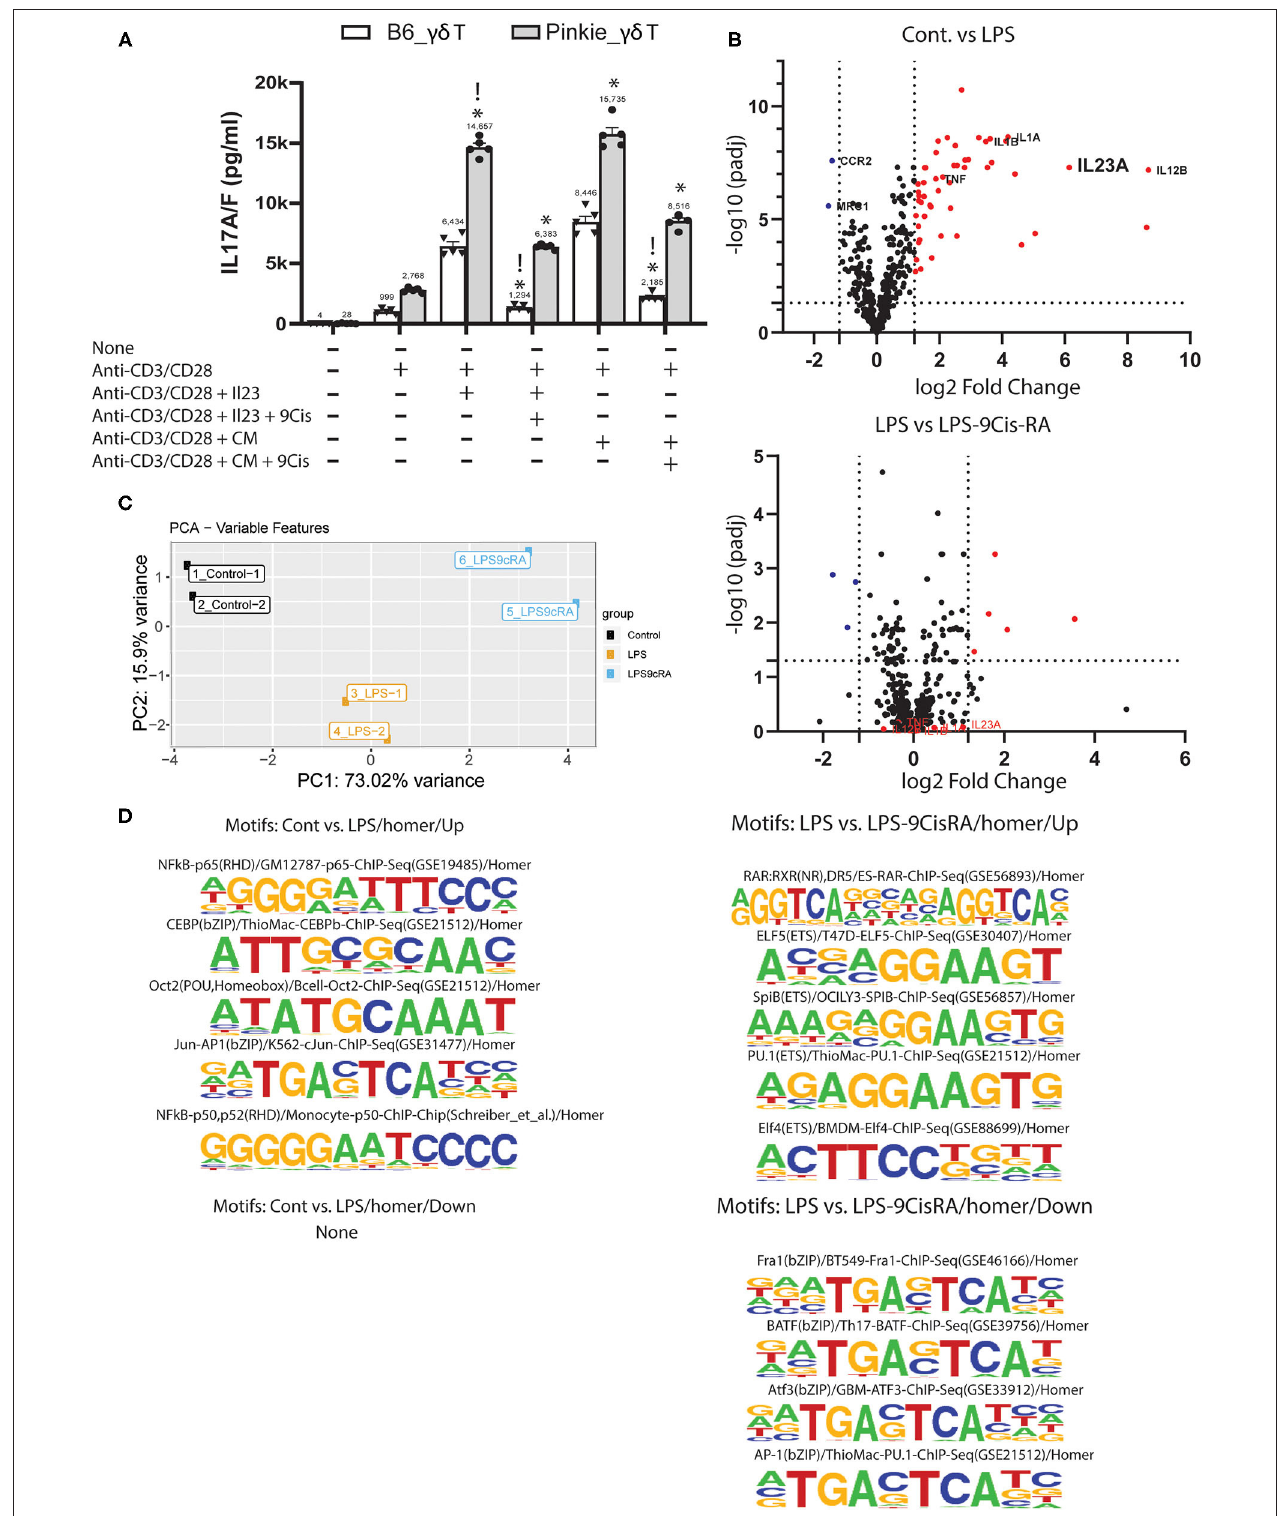
FIGURE 4 | Suppressive effects of 9-cis retinoic acid. (A) IL-17A/F concentration in supernatants of cultured γδ T cells isolated with magnetic beads from C57BL/6 or Pinkie spleens. Cells are stimulated with anti-CD3/CD28 beads or beads plus recombinant IL-23 without or with addition of 100 µ M 9-cis retinoic acid (RA).